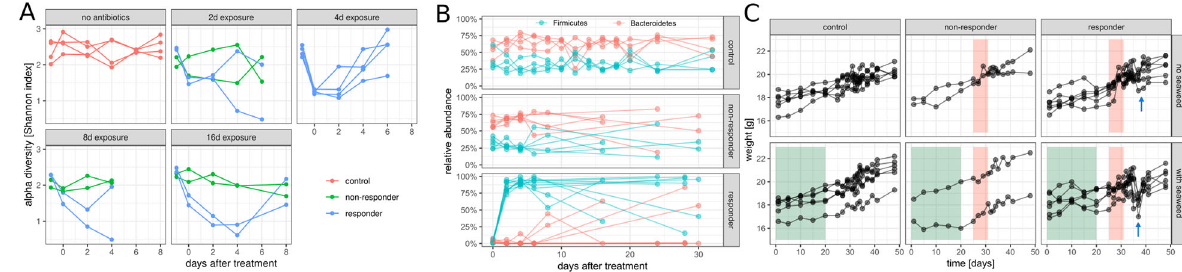
Fig. 3 Temporal dynamics in non-responder and responder mice following antibiotic and diet treatments. A Alpha diversity (Shannon index) dynamics after antibiotics treatment in the duration experiment. Each point denotes a single sample and samples from the same mouse are connected by lines. Colors denote responder status. B Dynamics of Bacteroidetes and Firmicutes phyla in the antibiotic duration experiment. C Mouse weights in the diet experiment. Green areas denote seaweed diet treatment windows and red areas denote antibiotics treatment windows. The blue arrows indicate transient weight loss in responder mice a few days following the end of antibiotic treatment (day 35 – 40). Responders vs. controls Mann – Whitney U p = 0.03 ( n = 48) and seaweed diet responders vs. normal chow responders p = 0.02 ( n =